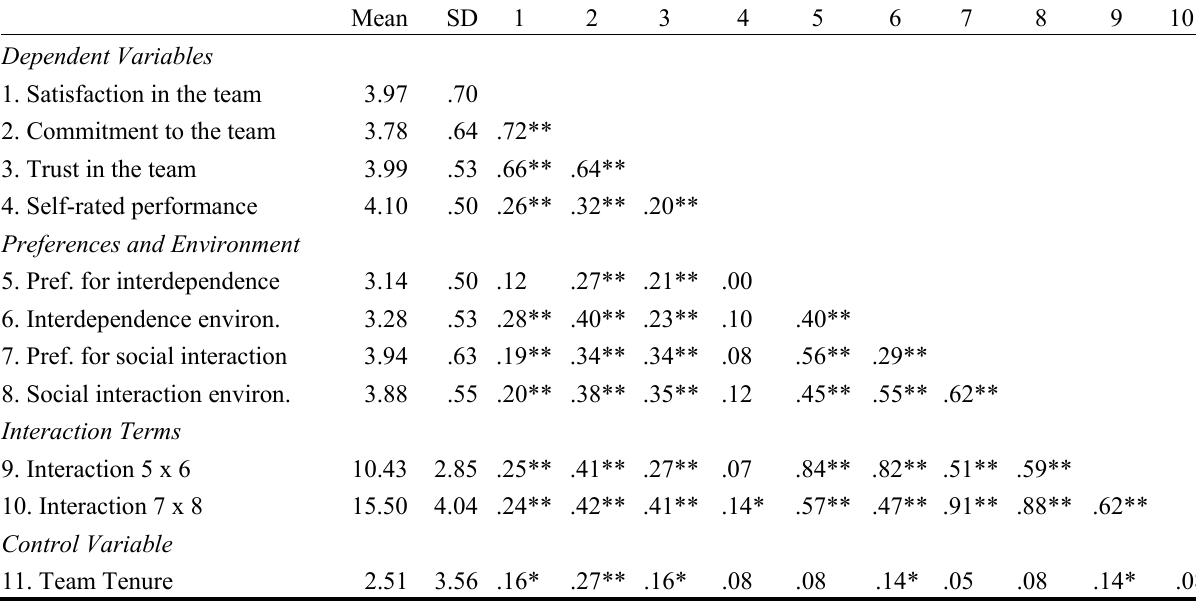
Table 1. Means, standard deviations and